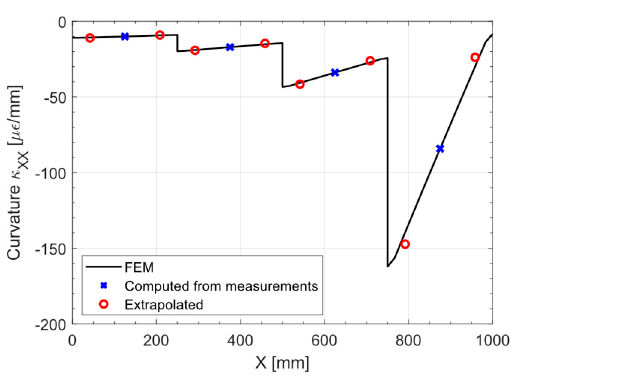
Figure 10 . Out-of-plane tip loading: normalized curvature 𝜉 (cid:3025)(cid:3025) pre-extrapolation.